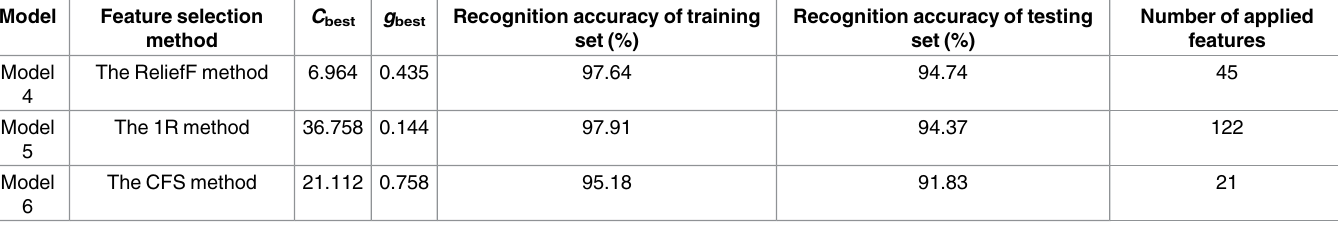
Note: Only the best SVM model for the image recognition of the four alfalfa leaf diseases is shown when the features were selected using the ReliefF method or 1R